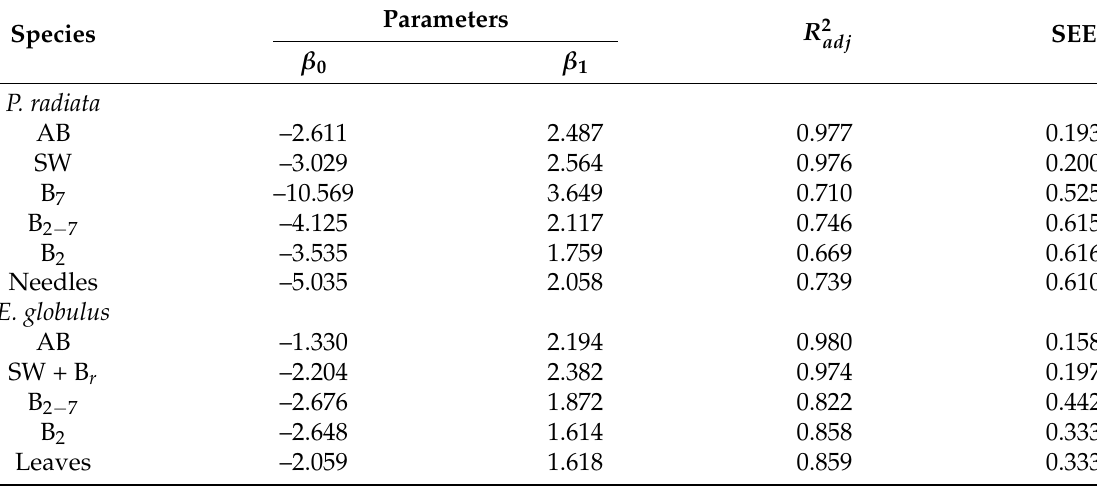
Table 2. Biomass fraction equations [29]. AB = aboveground biomass; SW = stem wood